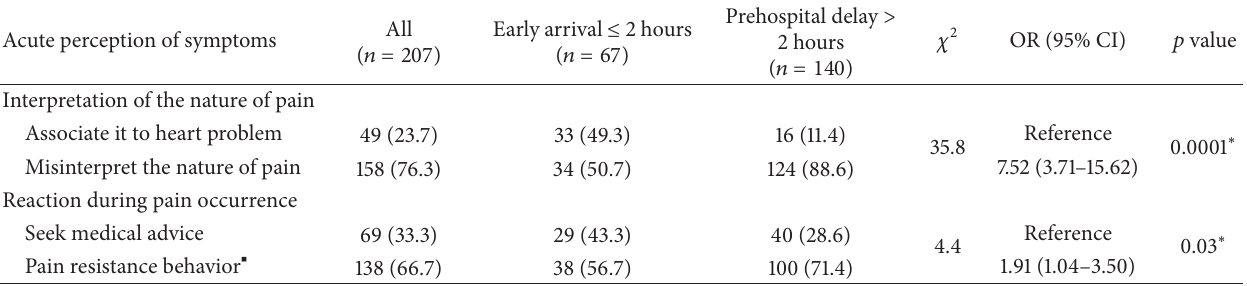
Table 2: Prehospital delay in relation to the acute perception of